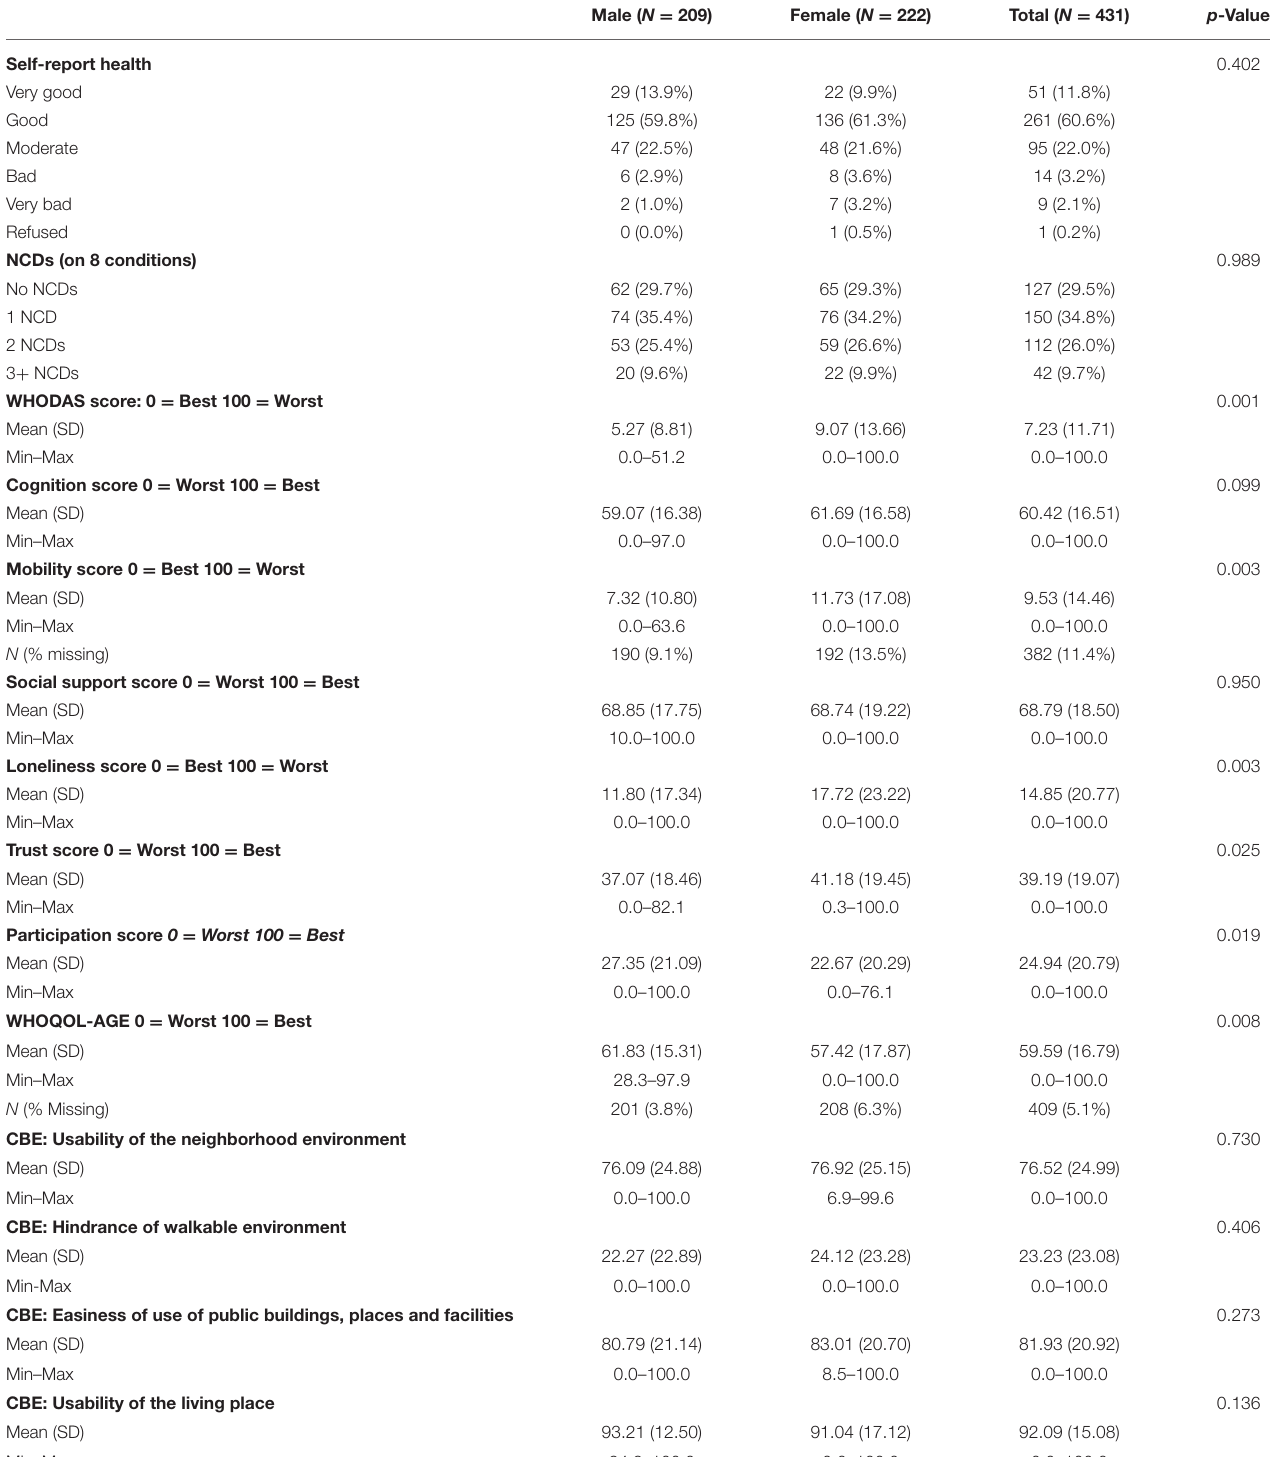
TABLE 2 | Descriptive statistics ( N =